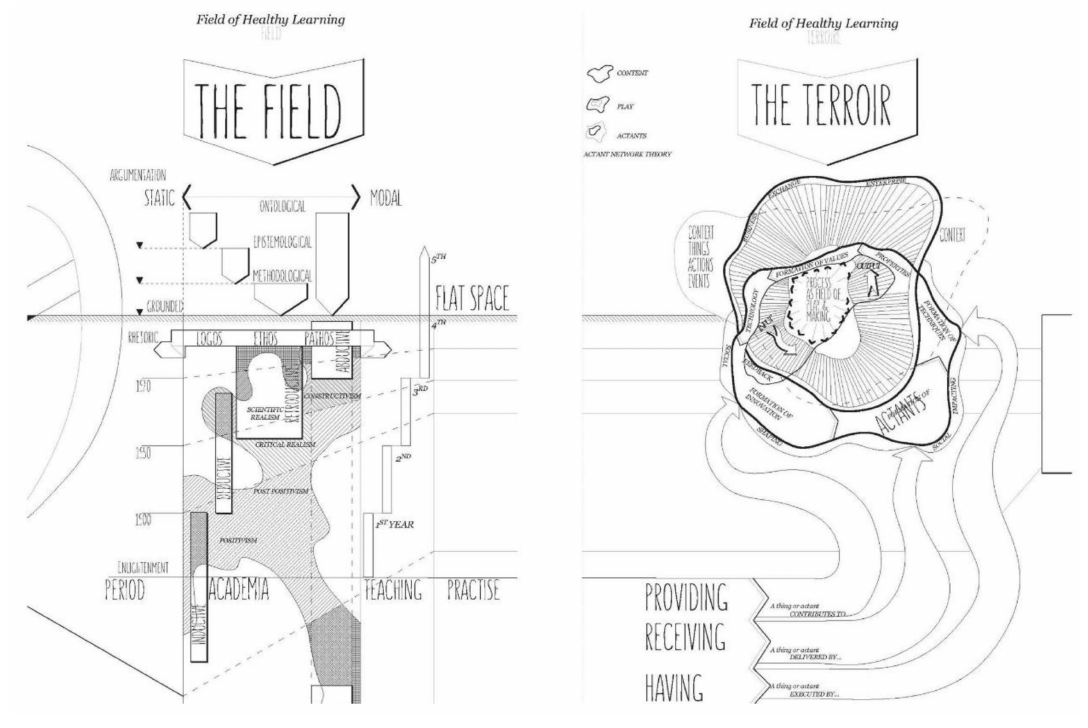
Figure 5. The field and terroir of learning (Source: Simon Kay-Jones,